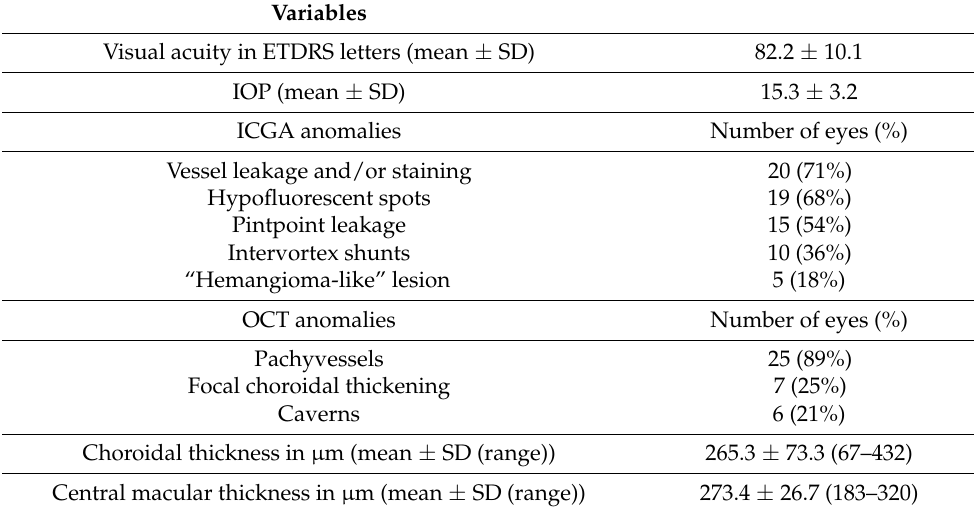
Table 2. Ophthalmological characteristics of included patients. ETDRS: Early Treatment Diabetic Retinopathy Study; ICGA: indocyanine green angiography; IOP: intraocular pressure; OCT: optical coherence tomography; SD: standard